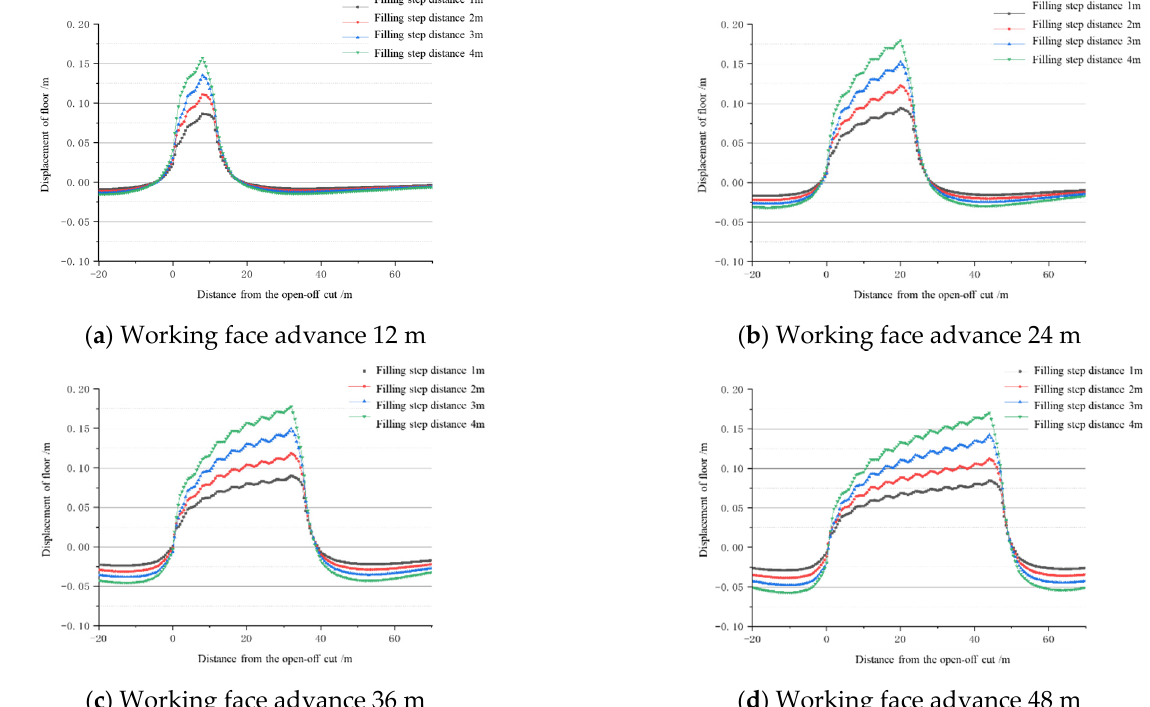
Figure 11. Floor displacement under different filling steps of paste-filling working face.